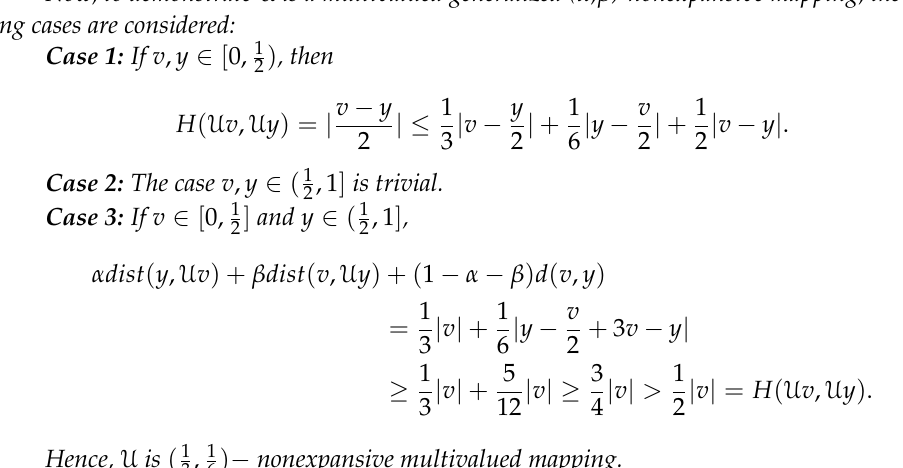
Table 1. Convergence comparison of Iteration Processes for different choices of initial points.